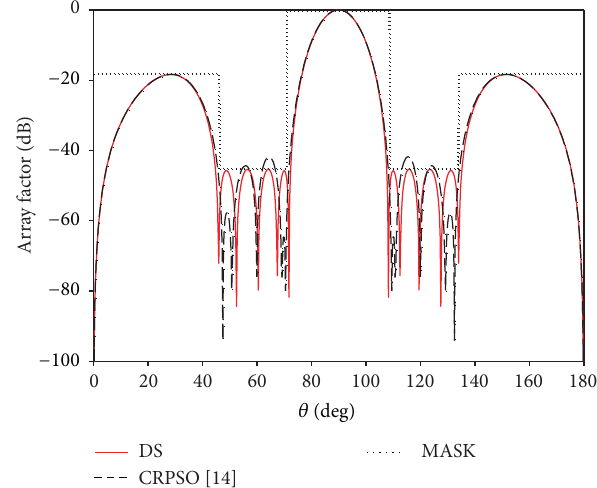
Figure 1: The radiation patterns with wide nulls at [46 ∘ , 71 ∘ ] and [108 ∘ , 134 ∘ ] obtained by DS and CRPSO [14] for the first example (12 elements).